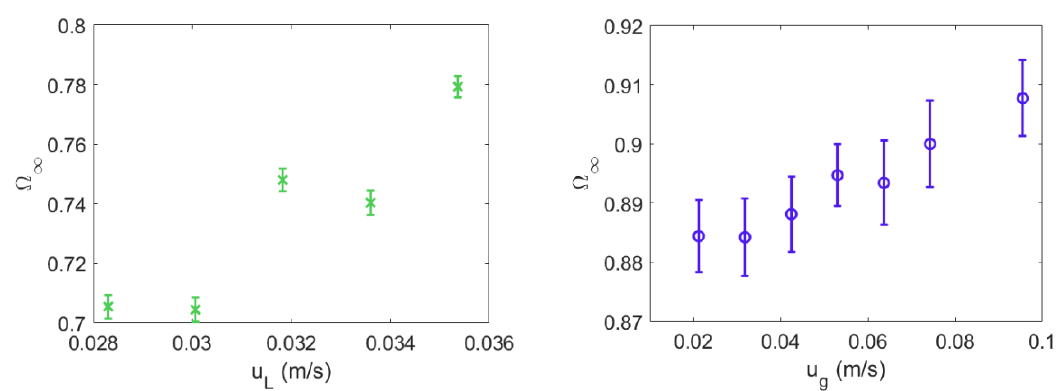
Figure 5 . Asymptotical Shannon entropy as a function of the superficial fluid velocity: LSFB ( left ) and GLSFB ( right ).